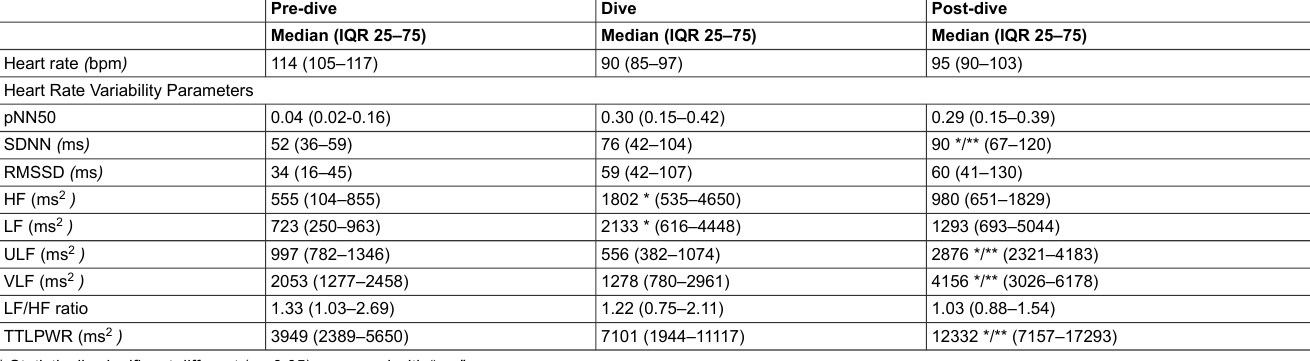
Table 2: Changes in heart rate and different heart rate variability parameters before submersion, during diving and after resurfacing.